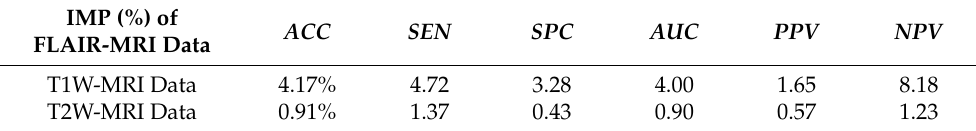
Figure 13. Highest performances of three MRI sequence datasets. Table 10. Performance improvement of FLAIR data against T1W and T2W data.